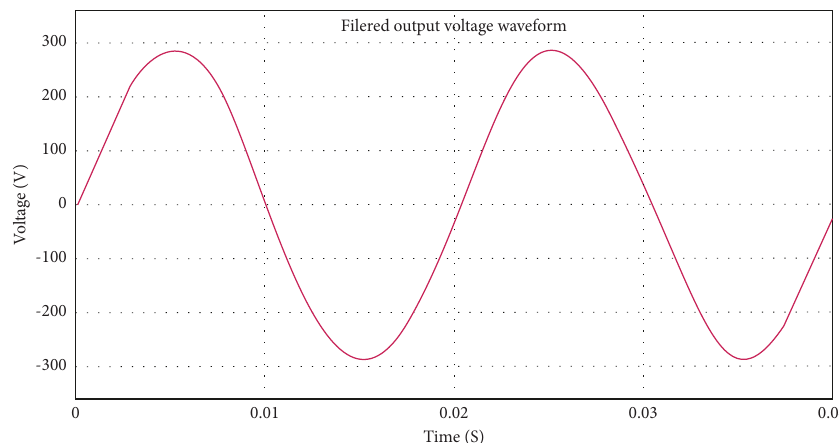
Figure 7: Te output voltage waveform of a single phase seven-level inverter with a flter.